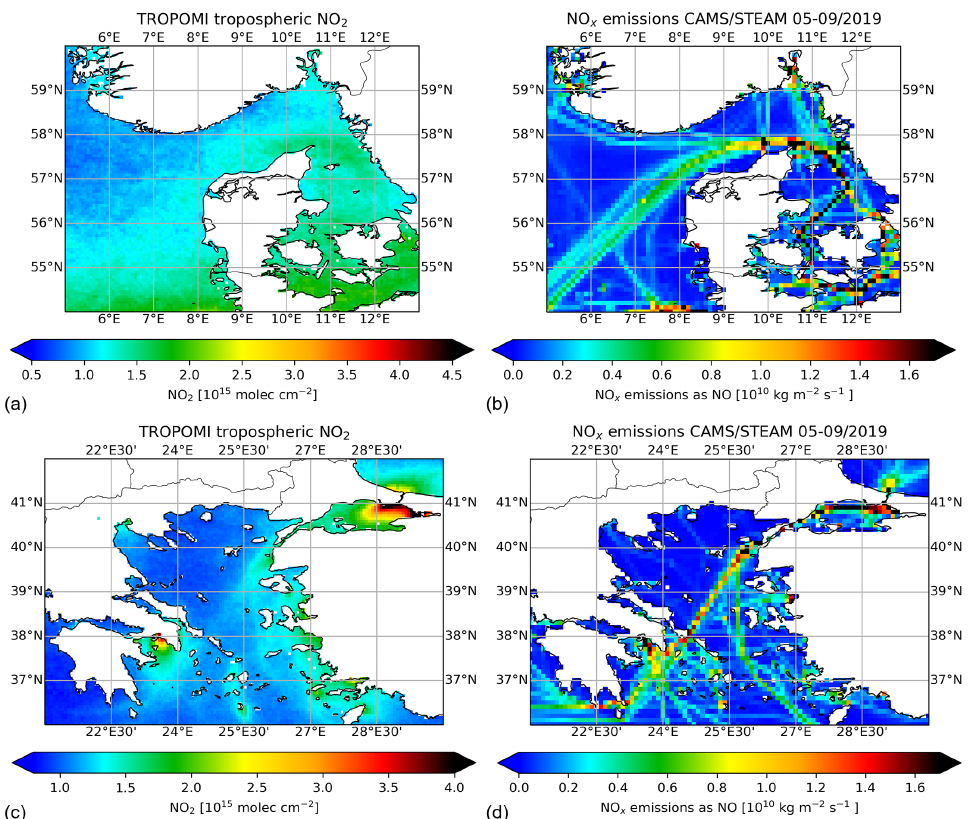
Figure 2. The 2019 summertime mean (May–September) tropospheric NO 2 columns from TROPOMI (a, c) and summertime mean NO x emissions from the CAMS/STEAM emission inventory ( b, d ; Granier et al., 2019; Johansson et al., 2017) of shipping lanes around Denmark (a, b) and the eastern Aegean Sea (c, d) for the first time detected with satellites.